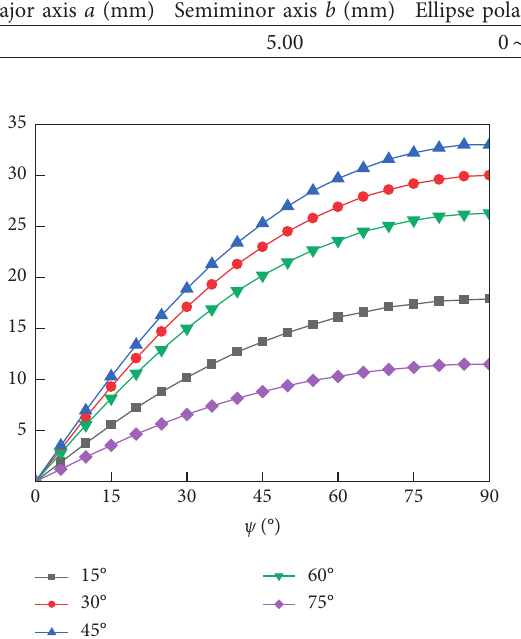
Figure 7: Variation of K III with elliptic polar angle